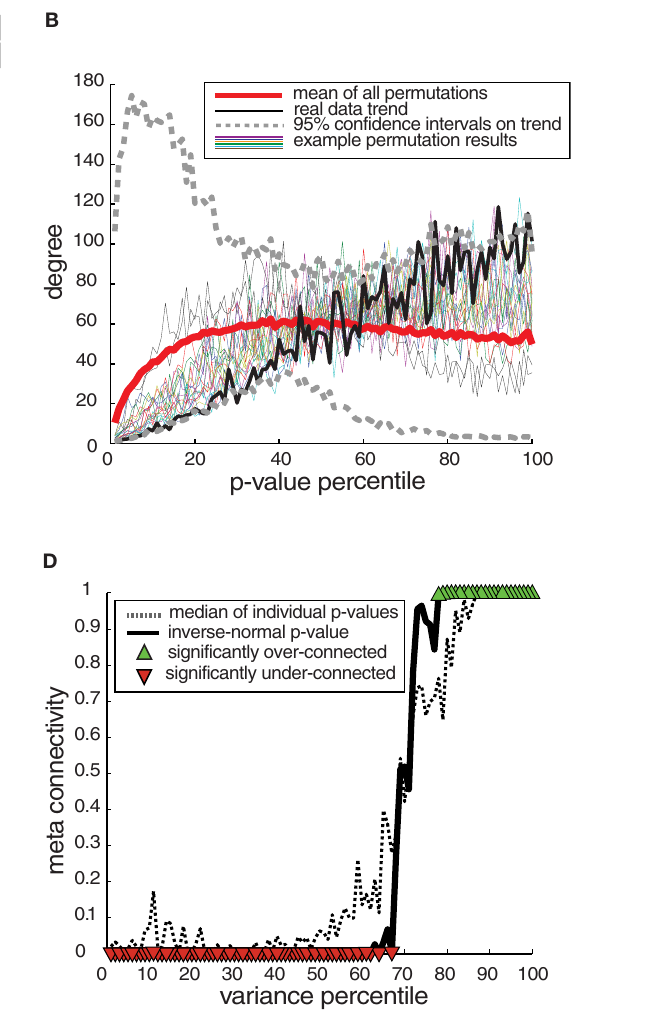
trend for DE genes is a generic trend of all comparisons, because the permutation bounds encompass the real comparison and because the mean permutation trend is similar to the actual trend. (C) Variability (transcript expression variance) plotted compared to degree – example from amygdala dataset (D) Meta-analysis of variability–connectivity relationship including all